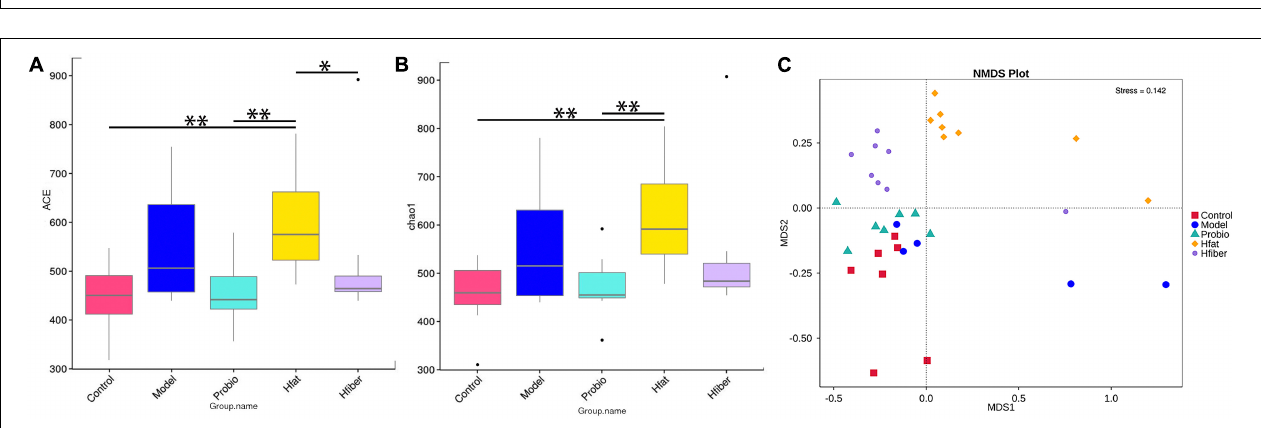
FIGURE 5 | Diversity in microbiota-community structure in different rat groups. (A) ACE indice. (B) Chao1 indice. * p < 0.05, ** p < 0.01. (C) NMDS. Stress < 0.2, p <